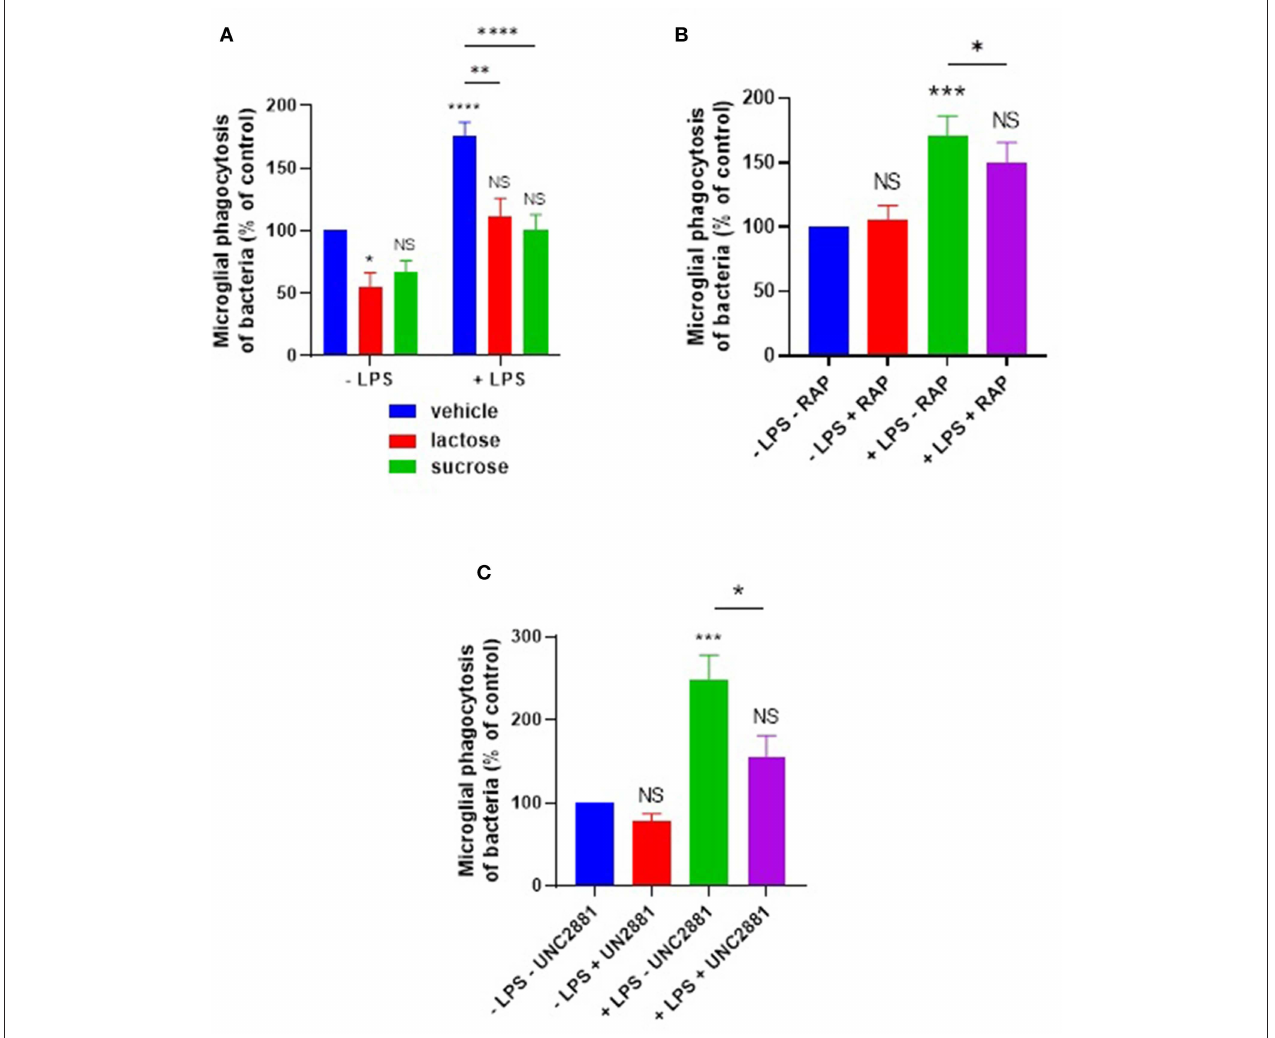
FIGURE 6 | LPS-induced phagocytosis of bacteria by primary microglia is inhibited by sugars, or by blocking microglial LRP1 or MerTK. Primary rat microglia stimulated by LPS (100ng/ml) for 24h increased their phagocytosis of E. coli compared to “–LPS” control, inhibitable by (A) 50mM lactose or sucrose, (B) RAP (250nM), or (C) UNC2881 (200nM). Note that a statistically significant difference between “–LPS + lactose” and “ + LPS + lactose” was observed in (A) . Values are means ± SEM of at least three independent experiments. Statistical comparisons were made via two-way ANOVA. NS p ≥ 0.05, * p < 0.05, ** p < 0.01, *** p < 0.001, **** p < 0.0001 vs. controls, except where indicated by bars over relevant